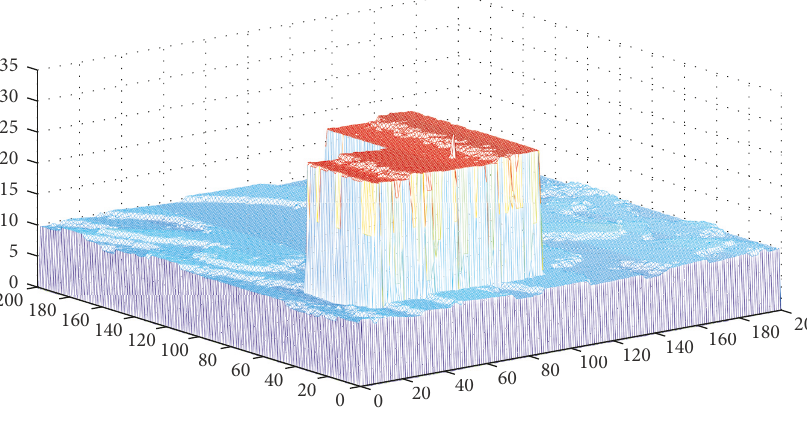
Figure 22: Imaging results.